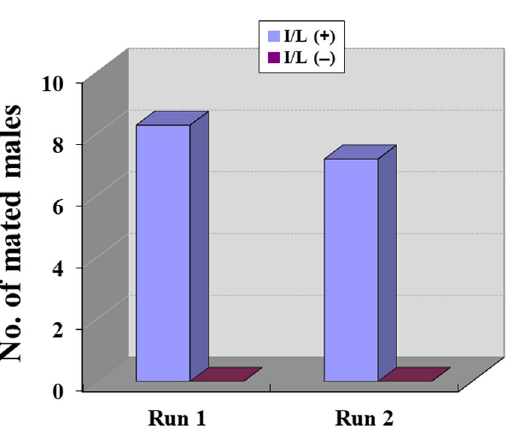
Figure 3. Mating competition between I/L-fed and I/L-unfed males of Parantica sita . All of the males had been maneuvered into possessing the sex pheromone before starting the experiment. Experiments were replicated twice. The numbers of I/L-fed males [I/L( + )], I/L-unfed males [I/L( − )], and females potentially engaged in the mating behaviour at any time point during the experiment for Runs 1 and 2, were 14/14/20 and 12/12/18, respectively. The difference in the copulation rate between I/L-fed and I/L-unfed males was significant ( p <